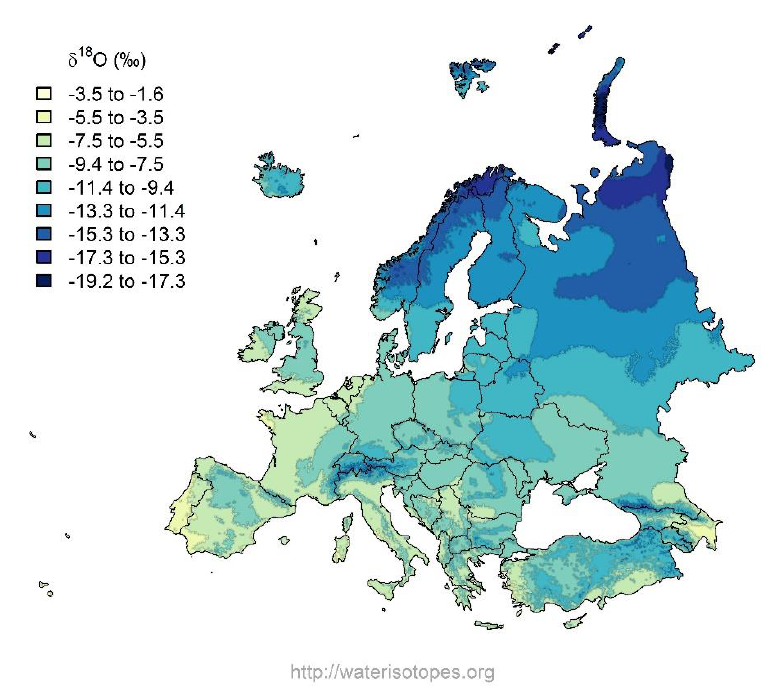
Figure 5. Distribution of oxygen stable isotope ratio in the precipitation in Europe